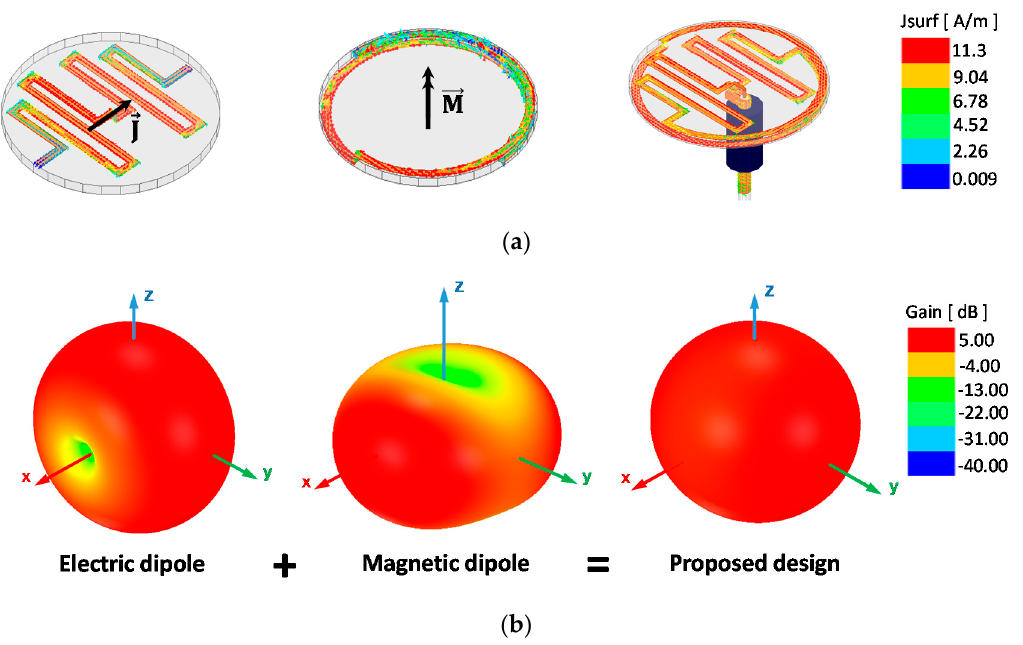
Figure 2. Design concept: ( a ) current distribution and ( b ) 3D radiation pattern.